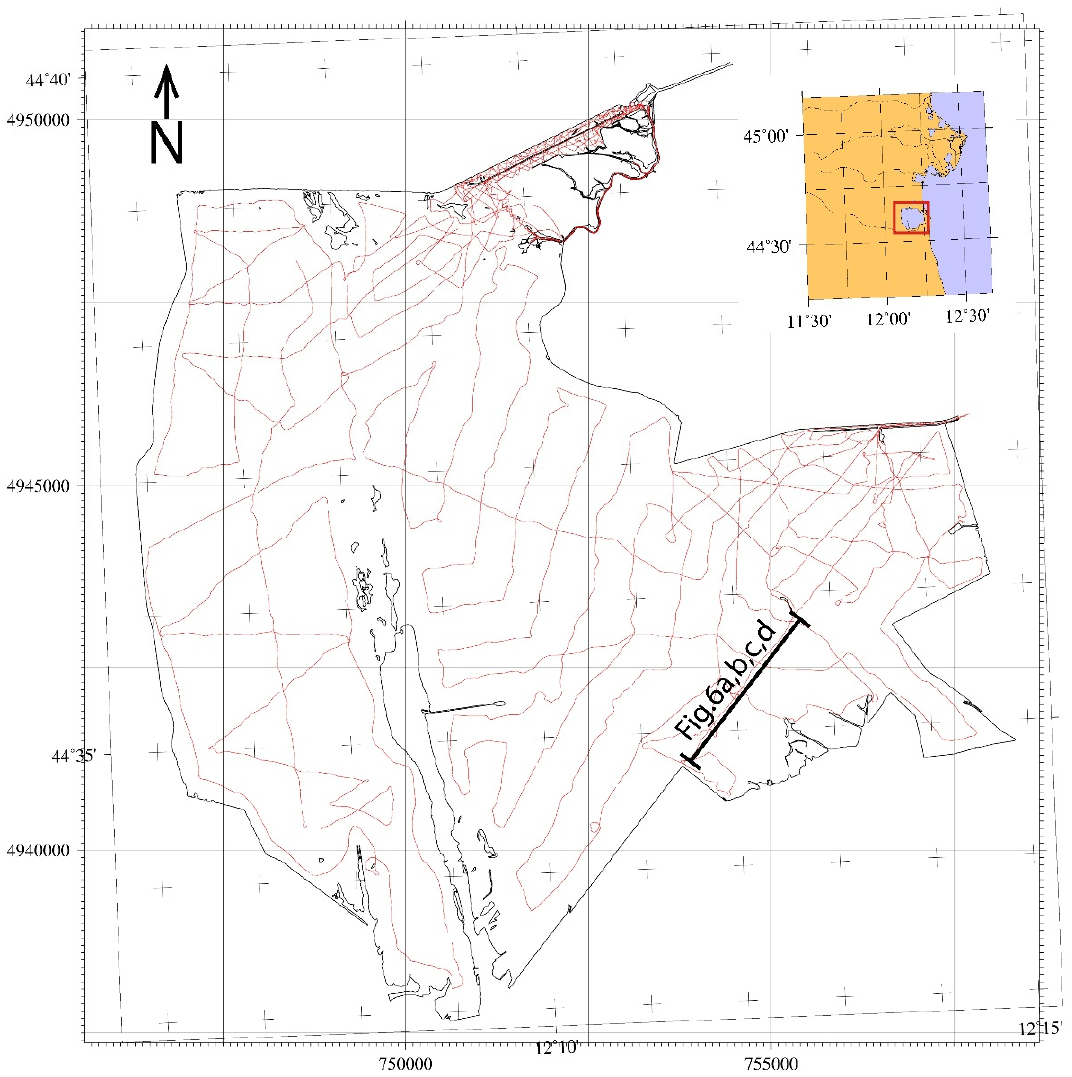
Figure 2. Survey lines were performed in the study area (red lines) including bathymetric and seismic reflection data. Projection UTM 32N.